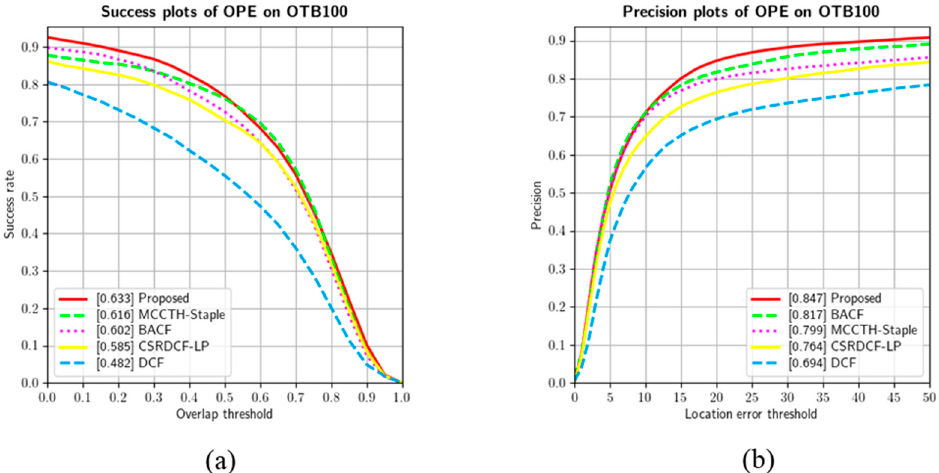
Figure 14. Evaluation Graph of OTB-100 for All Attributes ( a ) Success Plots Graph of OTB-100, ( b ) Precision Plots Graph of OTB-100. Table 5. Overall performance evaluation results of